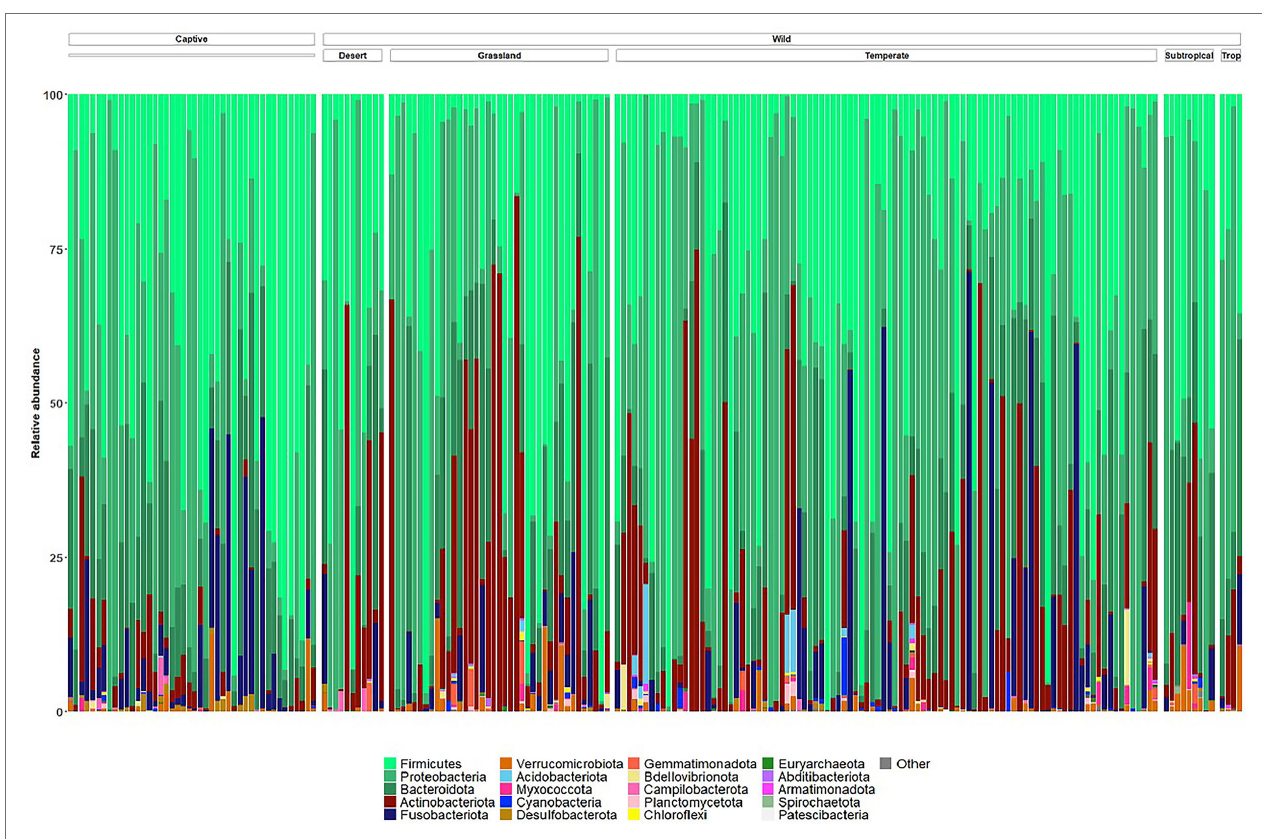
FIGURE 3 | Taxonomy bar plots of relative frequency of bacteria present in all wild and captive echidna scats at the phylum level. Samples are firstly organised into ‘captive’ and ‘wild’ samples, and the wild samples are further organised by climate class ( Supplementary Table S1 ). Top 20 most abundant phyla are coloured in figure; legend is labelled with most abundant taxa on the left to least abundant taxa on the right. Original and interactive QZV files to view bar plots are available in Supplementary Files